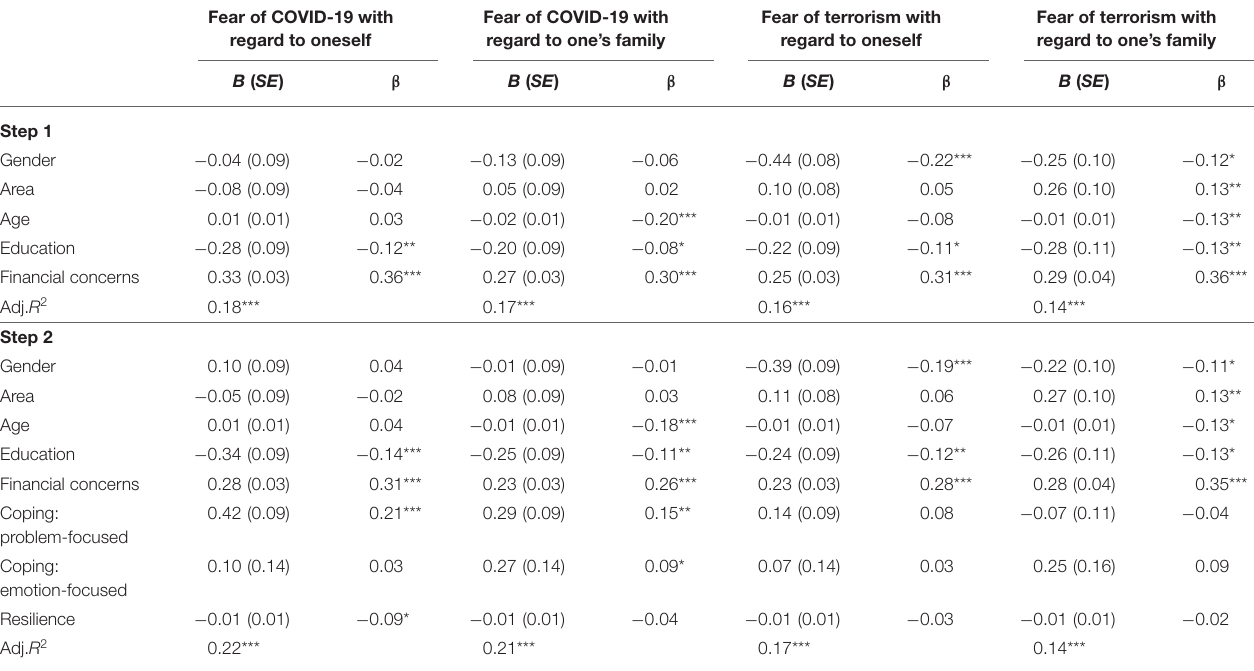
TABLE 4 | Multiple hierarchical regressions for fear of COVID-19 and terrorism ( N =